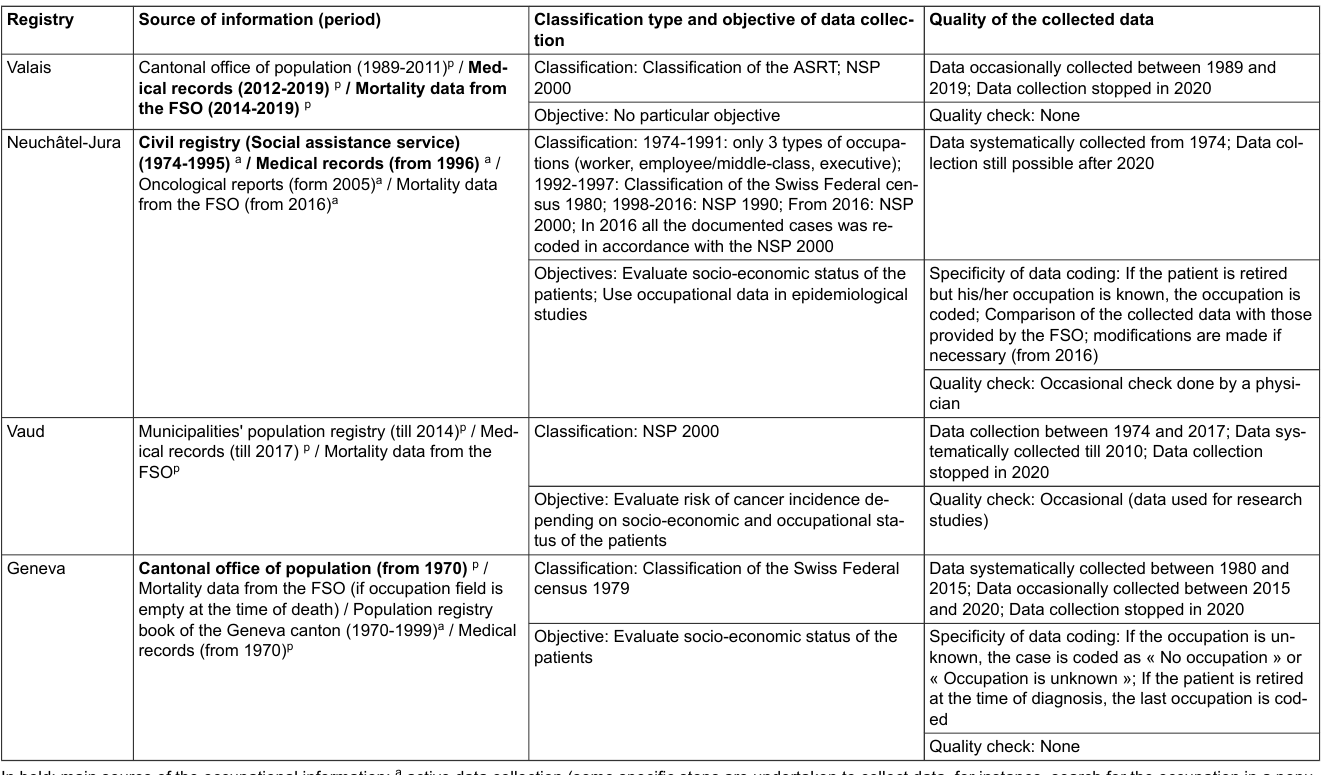
Table 1: Coding procedures of the occupational information among the five cancer registries of western Switzerland. Registry Source of information (period) Classification type and objective of data collec-